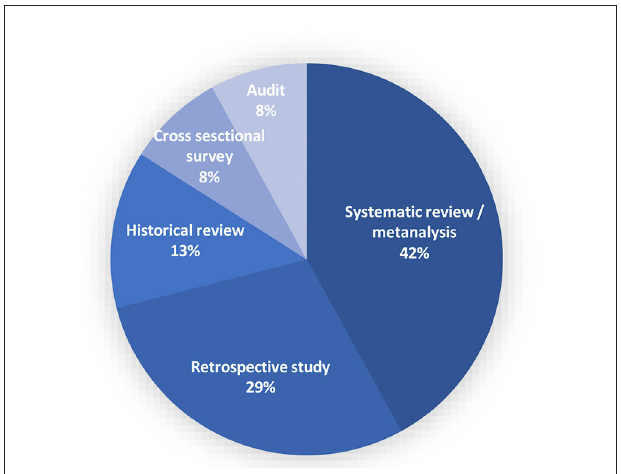
FIGURE 1 | The type of projects undertaken by medical